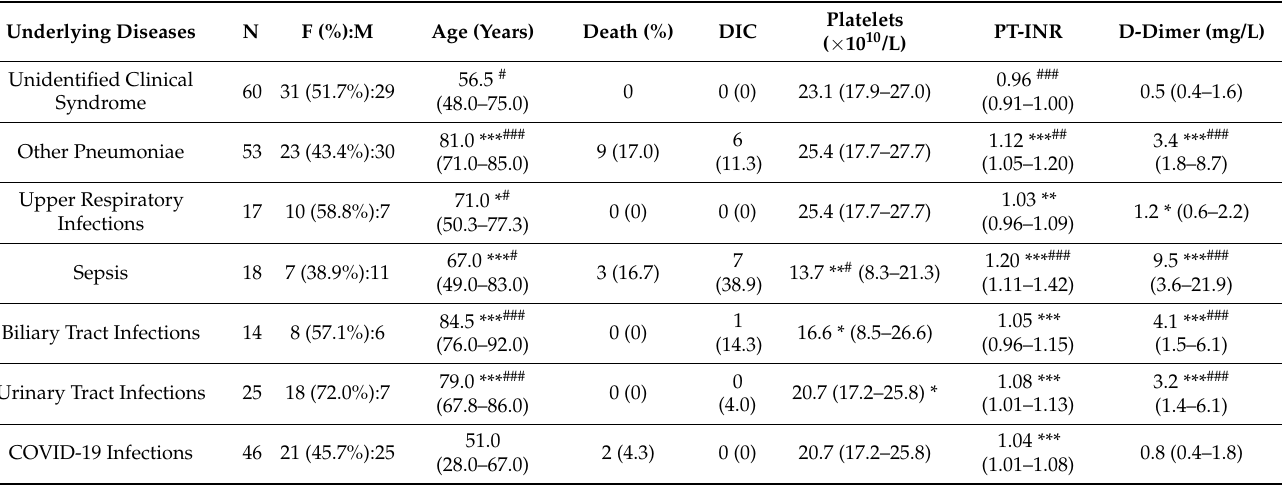
Table 1. Patients with various infections.